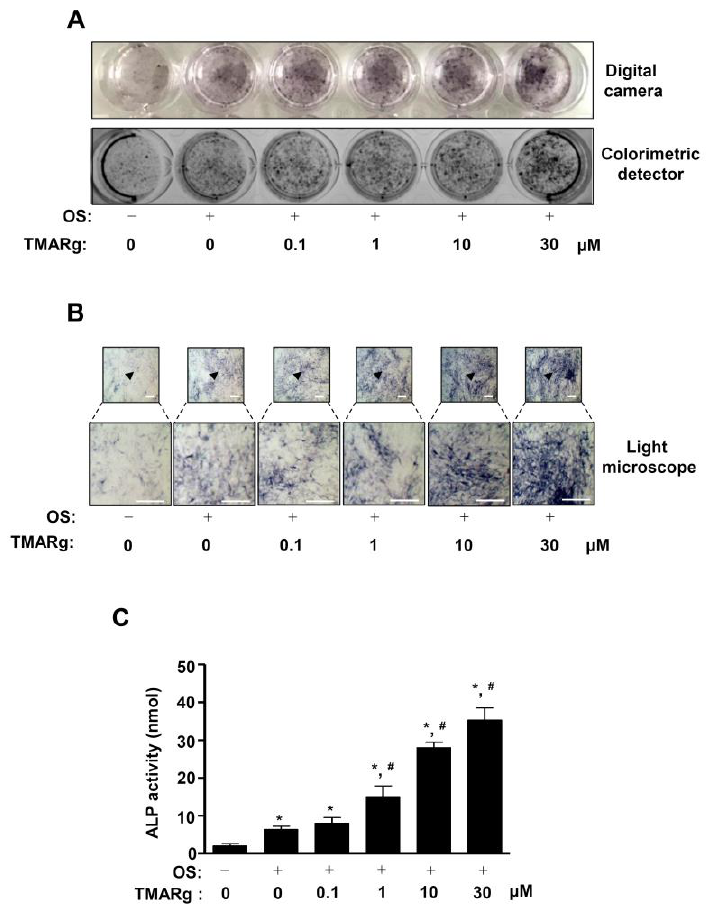
Figure 2. TMARg promotes early osteoblast differentiation. ( A , B ) Pre-osteoblasts were seeded onto 24-well plates (2 × 10 4 cells/well) and were cultured in osteogenic supplement medium (OS) containing 50 µg/mL L -AA and 10 mM β-GP in the absence or presence of TMARg (0, 0.1, 1, 10, and 30 µM) for five days. The levels of ALP staining were detected using a digital camera (upper) and a colorimetric detector (bottom) (A). ALP-stained cells were observed by using a light microscope (bottom: magnified images). The arrowhead indicates the magnified region (B). ( C ) After the cells were seeded onto 48-well plates (1 × 10 4 cells/well), ALP activity was measured at 405 nm using the Multiskan GO Microplate Spectrophotometer . Scale bar: 100 µm. The data are representative of the results of three independent experiments. Data represent the means ± SEMs of the experiments. *, p < 0.05 was considered significantly di ff erent, compared to the control. #, p < 0.05 was considered significantly di ff erent, compared to the